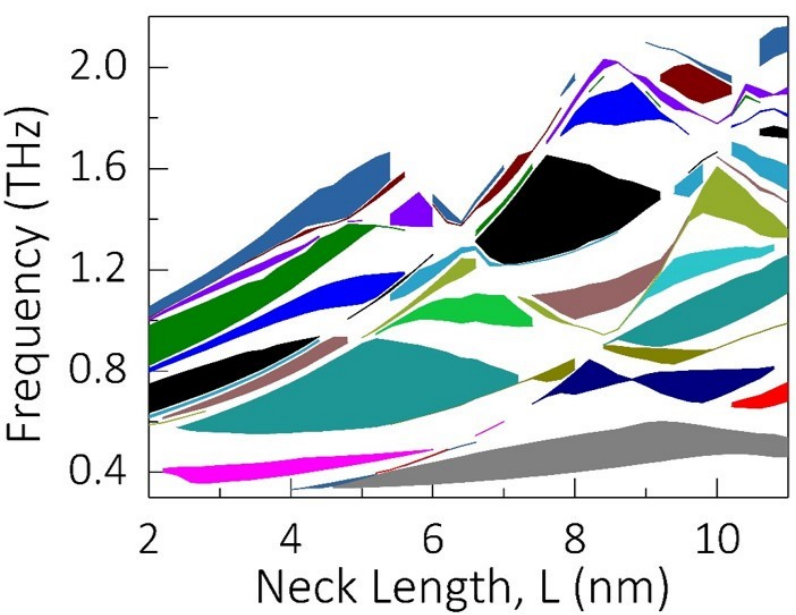
Figure 4. The phononic bandgap map which depicts the bandgaps plotted as a function of frequency for various neck lengths of the snowflake phononic crystal. The neck-length is continuously varied from 2 nm to 11 nm. Different colors indicate different phononic bandgaps appearing between two particular bands.